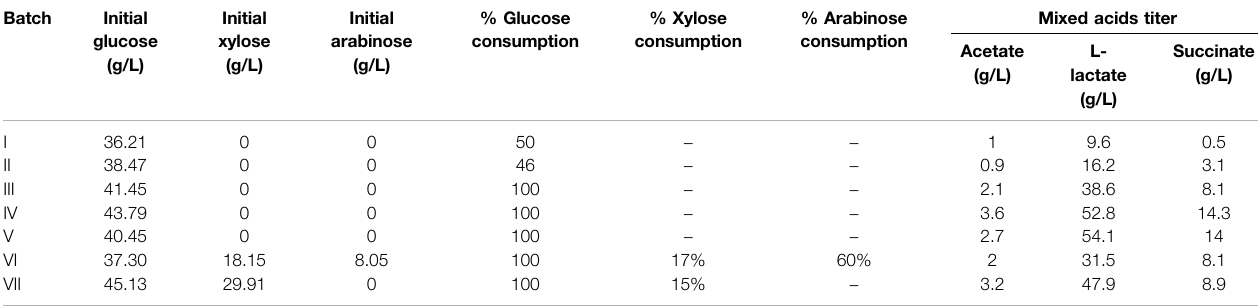
TABLE 2 | Fermentation kinetics of different cultivation strategies employed for production of mixed acids. Batch Initial